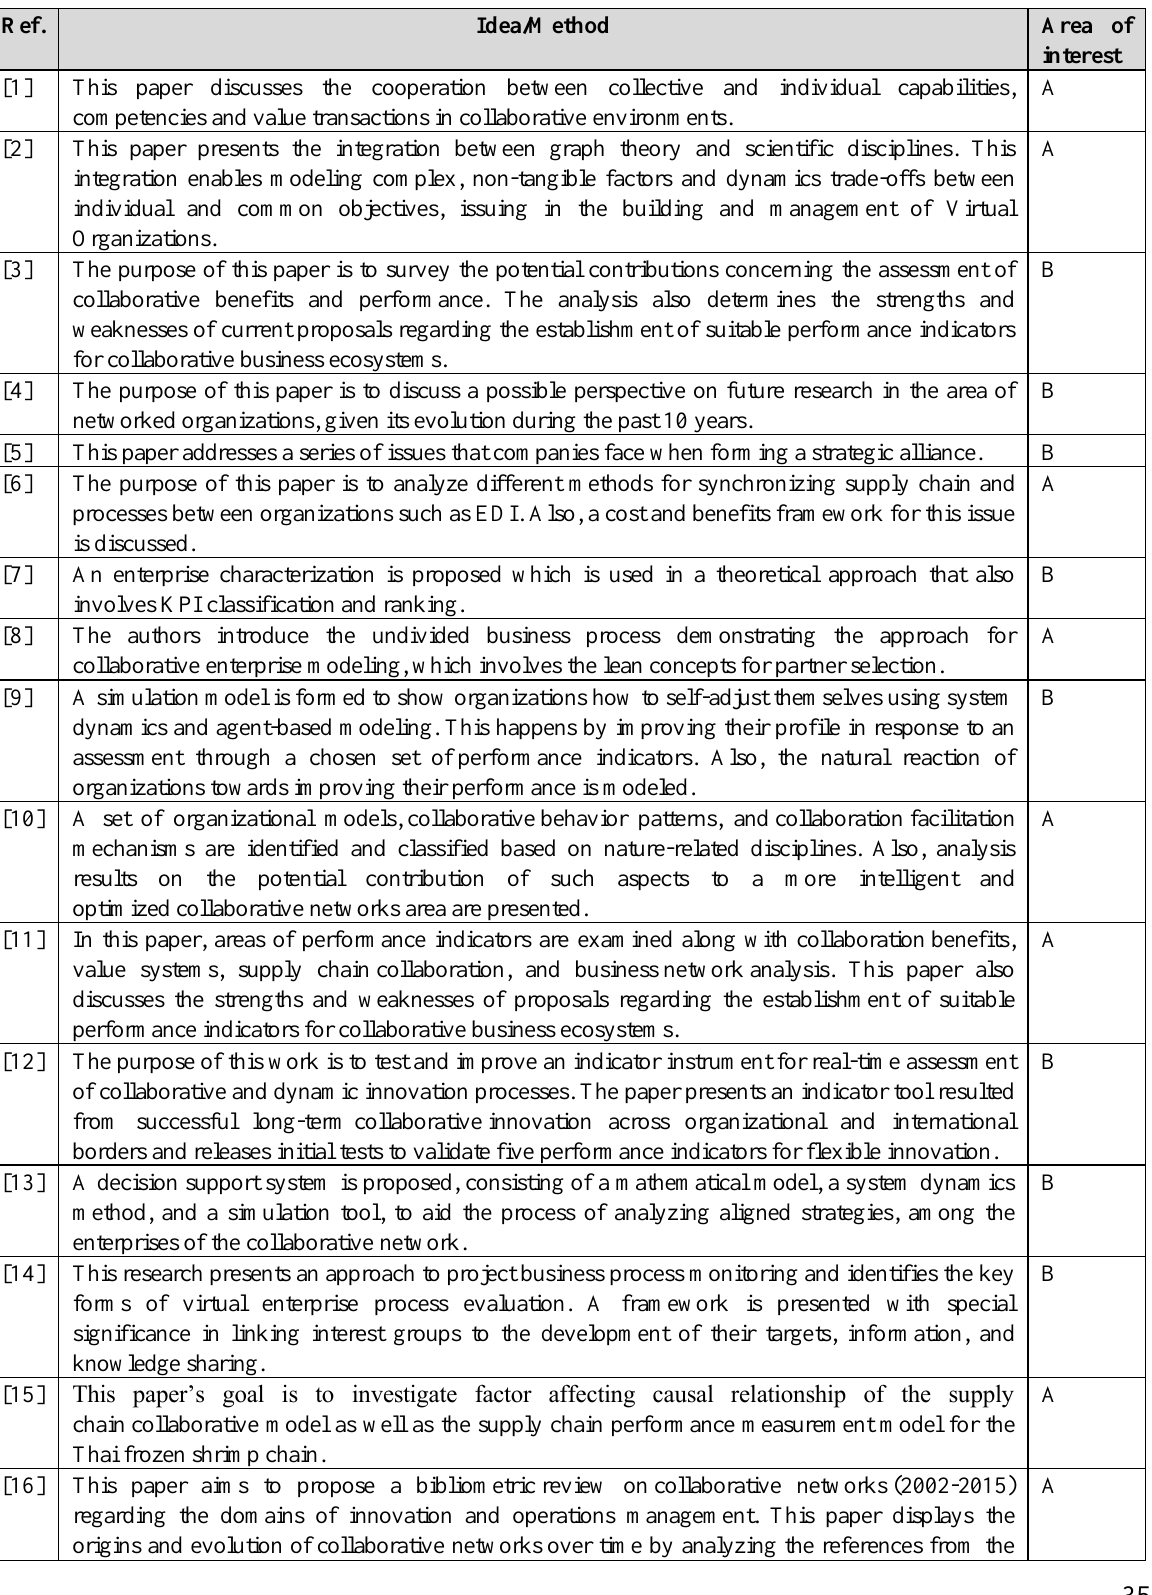
Table 1. Literature review articles and their area of interest